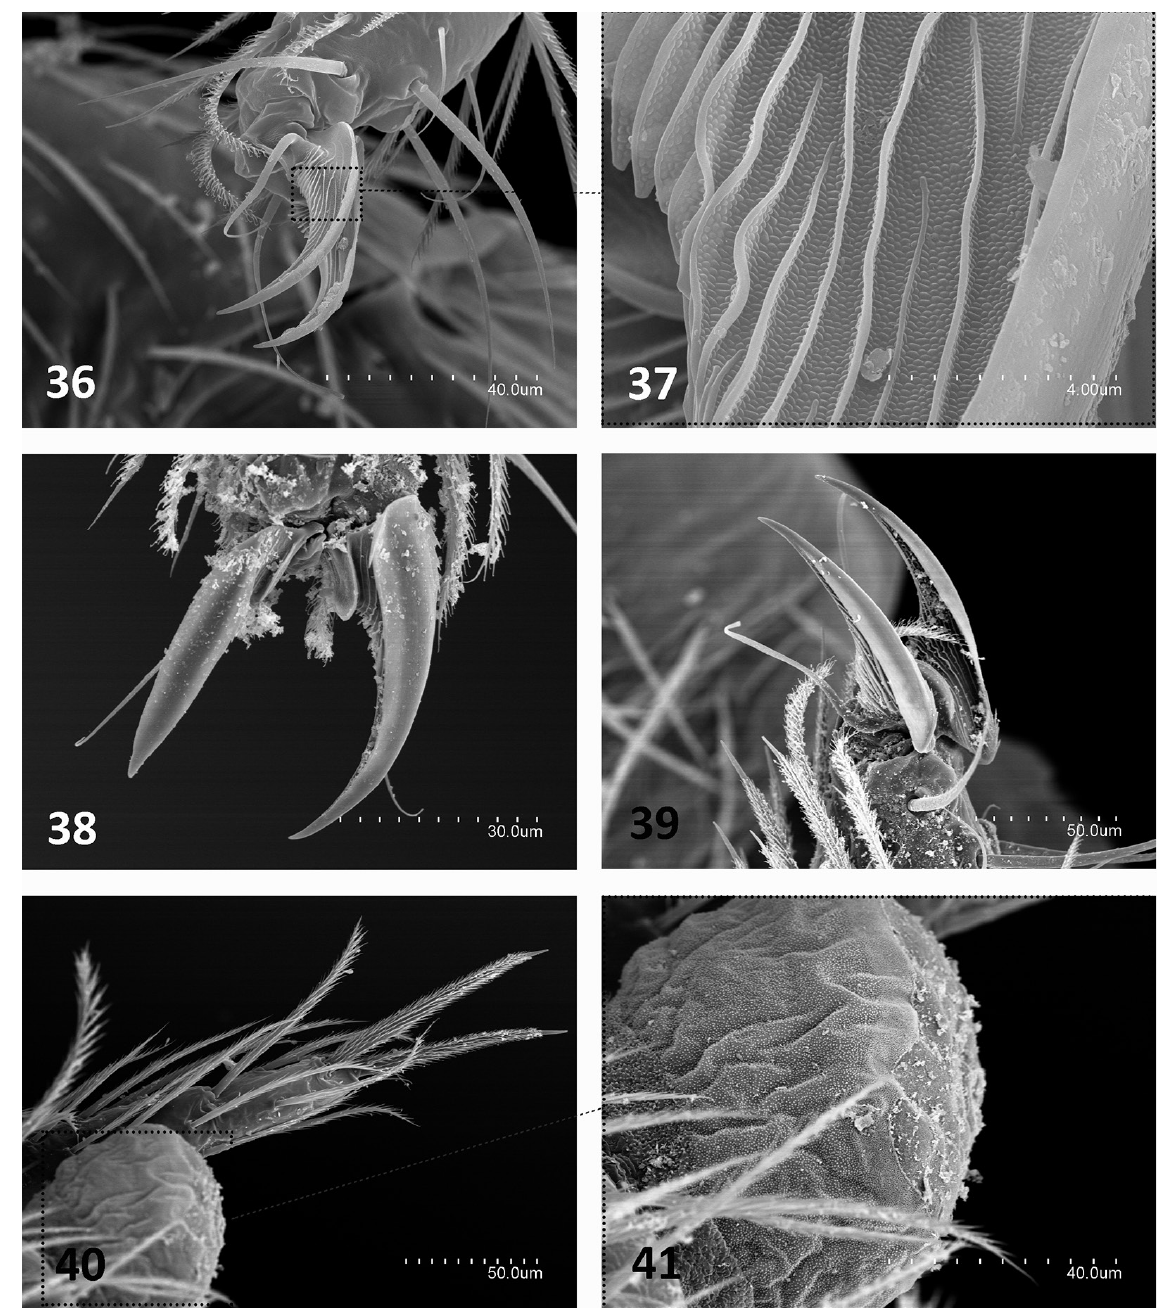
Figs 36–41. Plusiocampa ( Plusiocampa ) bonneti condei Sendra & Escolà, 2004, from Cova del Toll, Moià, Barcelona, Spain (Coll. AS). 36 . Lateral posterior pretarsus of metathoracic leg. 37 . Lateral detail of posterior claw of metathoracic leg. 38 . Frontal view of pretarsus of metathoracic leg. 39 . Lateral anterior view of pretarsus. 40 . Stylus and abdominal eversible vesicle of urosternite. 41 . Detail of abdominal eversible